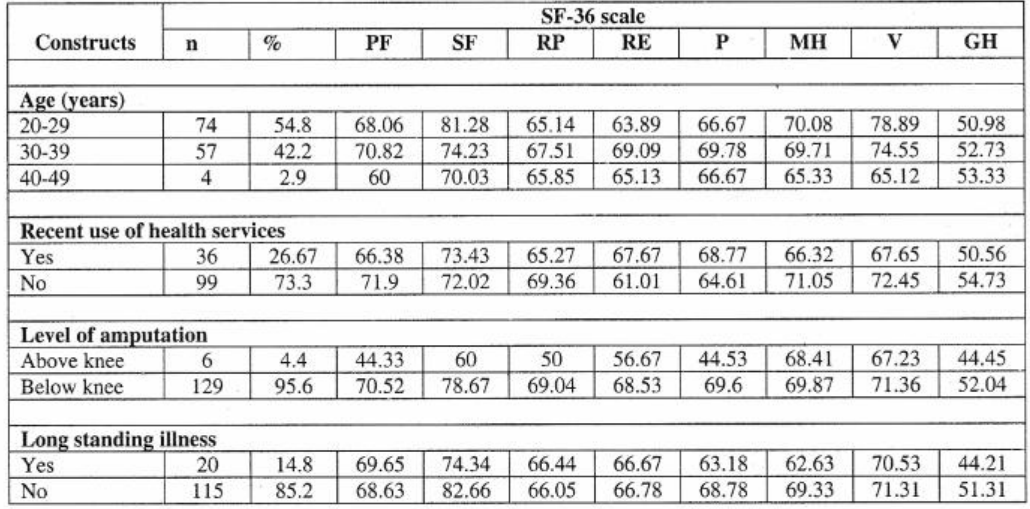
‘Age (years) 20.29